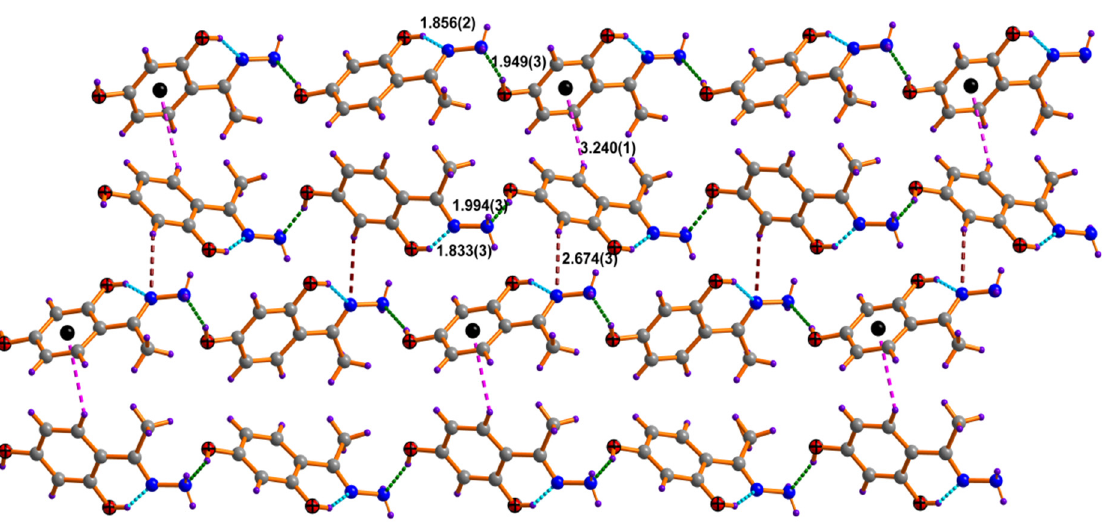
Figure 2. Packing diagram of compound 1 having two different molecules in the asymmetric unit. Compound 2 crystallizes in the triclinic space group P-1, showing two almost identical molecules within the asymmetric unit. In both molecules, the dihedral angle passes through phenyl moiety, making an angle of 2.55(9) ◦ and 0.75(13) ◦ . The other geometrical parameters within the hydrazine molecule are observed as usual. Interestingly, the compound shows an intramolecular hydrogen bonding between the hydrazine nitrogen atom and the hydrogen atom of the hydroxyl group adjacent to it. These intramolecular distances are found in the range of 1.791(3) to (1.810(4) Å, and the corresponding angle O–H ··· N was 144.2(2) ◦ to 147.1(2) ◦ , which indicates a significantly strong intramolecular hydrogen bond between these donors and acceptors. The packing diagram shows two molecules in an asymmetric unit are interconnected to each other via a hydrogen bonding mediated by an H 2 O molecule (Figure 3). The water molecule interacts with the oxygen and hydrogen atoms of an adjacent molecule, forming a β -plated sheet along the c-axis. These sheets are arranged in an ababab fashion along the c-axis. The other weak interac- tion was observed between methyl hydrogen and hydroxyl oxygen atom H25···O8 2.677(4) Å with a bond angle of 148.6° (3). Both molecules in the asymmetric unit are ar- ranged in a zig-zag manner, as shown in Figure 3.